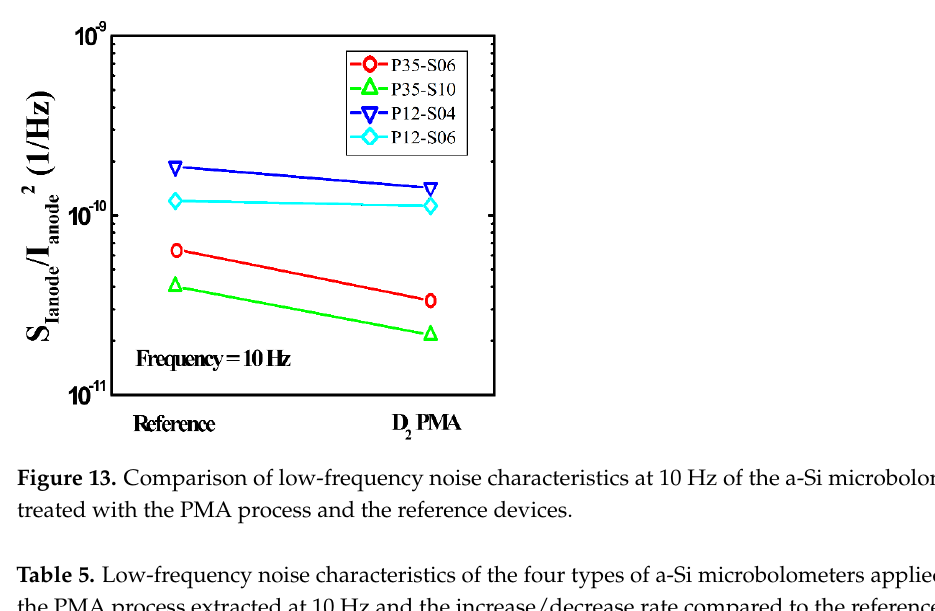
Figure 12. Comparison of noise characteristics normalized with I anodes of the four types of a-Si mi- crobolometers before (black solid lines) and after (red solid lines) applying the PMA process: ( a )